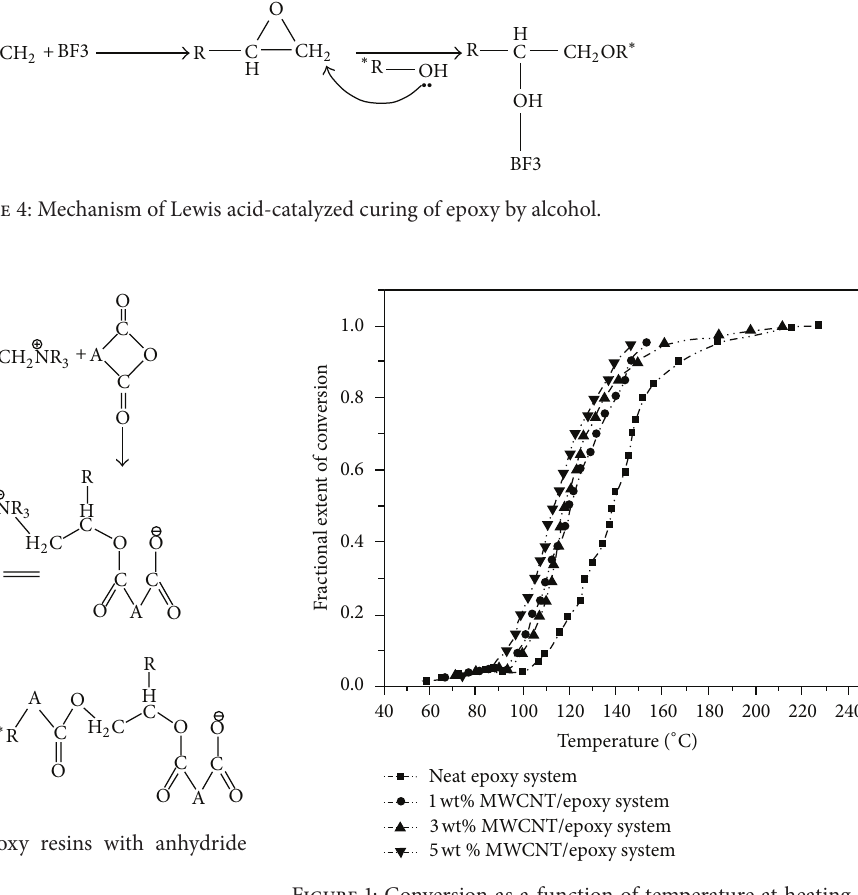
Figure 1: Conversion as a function of temperature at heating rate of 20 ∘ C/min for the neat epoxy and MWCNTs-filled epoxy systems. After